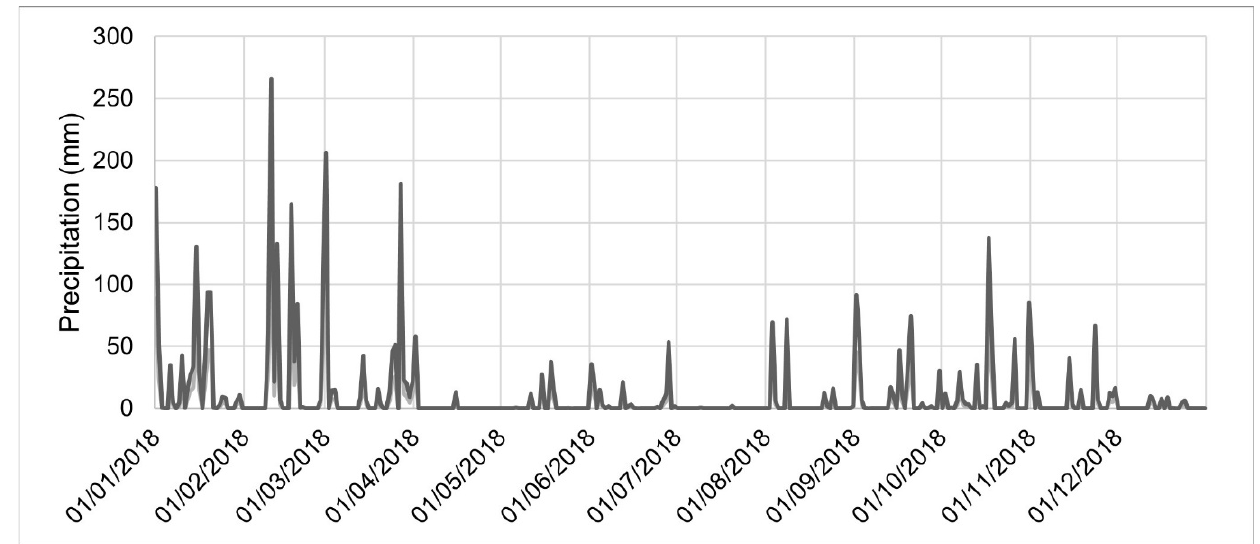
Figure 3. Daily precipitation (mm) in Cascavel city—PR throughout the year 2018. Data provided by